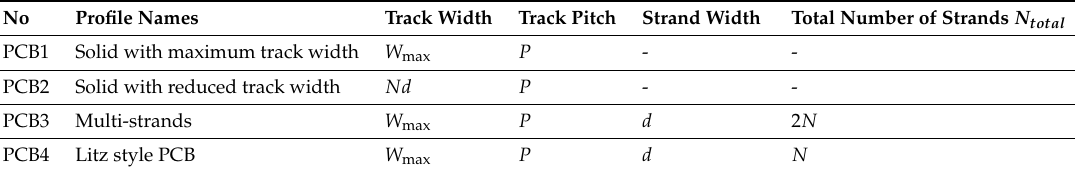
Table 1. Two layers PCB profiles and parameters.